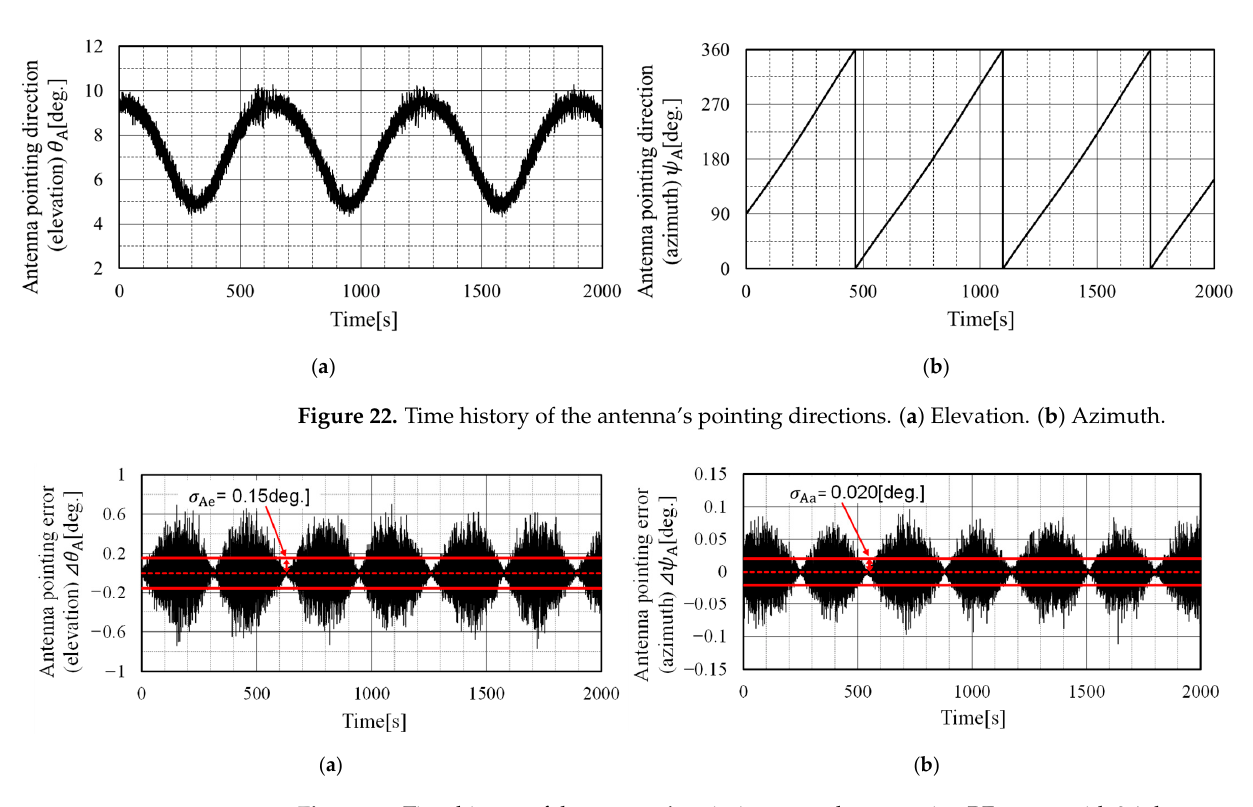
Figure 21. Time history of target command of antenna driving angle. ( a ) Elevation. ( b ) Azimuth.